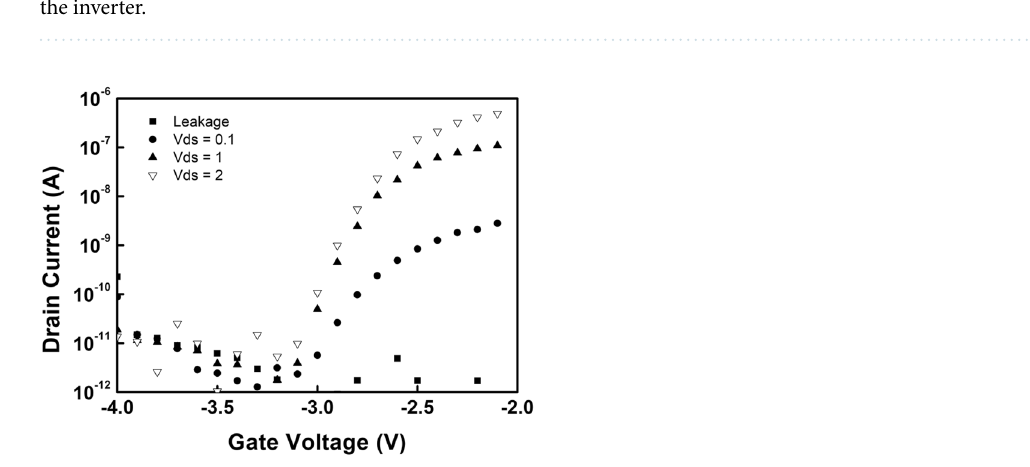
Figure 9. Transfer characteristics of interfacial oxidized gate insulator IGZO